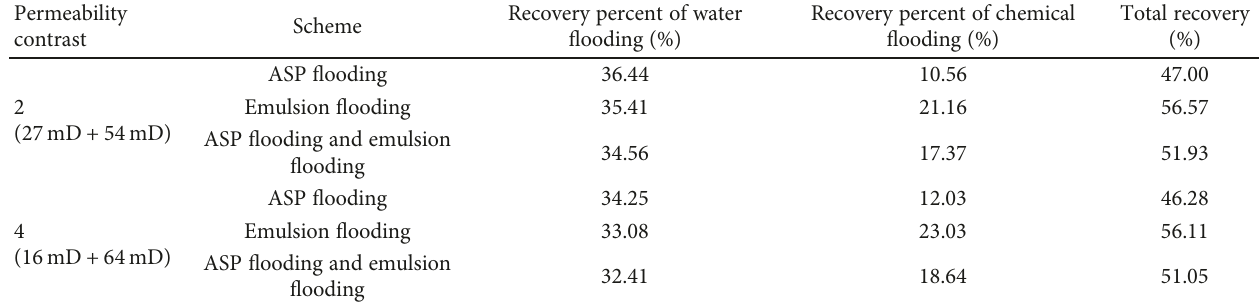
Table 3: Comparison of oil displacement e ffi ciency under transistor core.